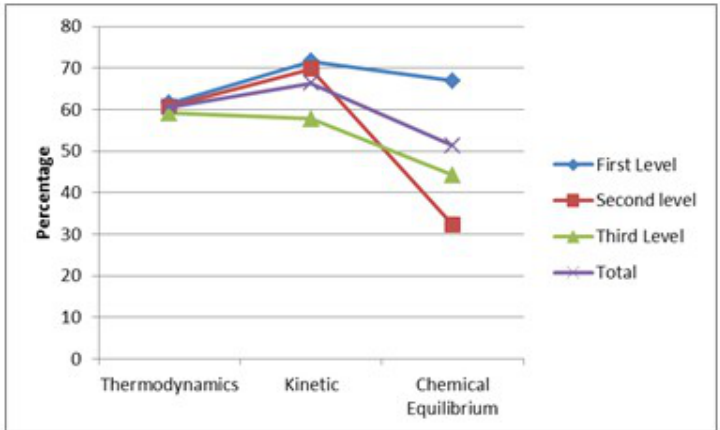
Figure 3. Global results on the three levels of knowledge structure for each